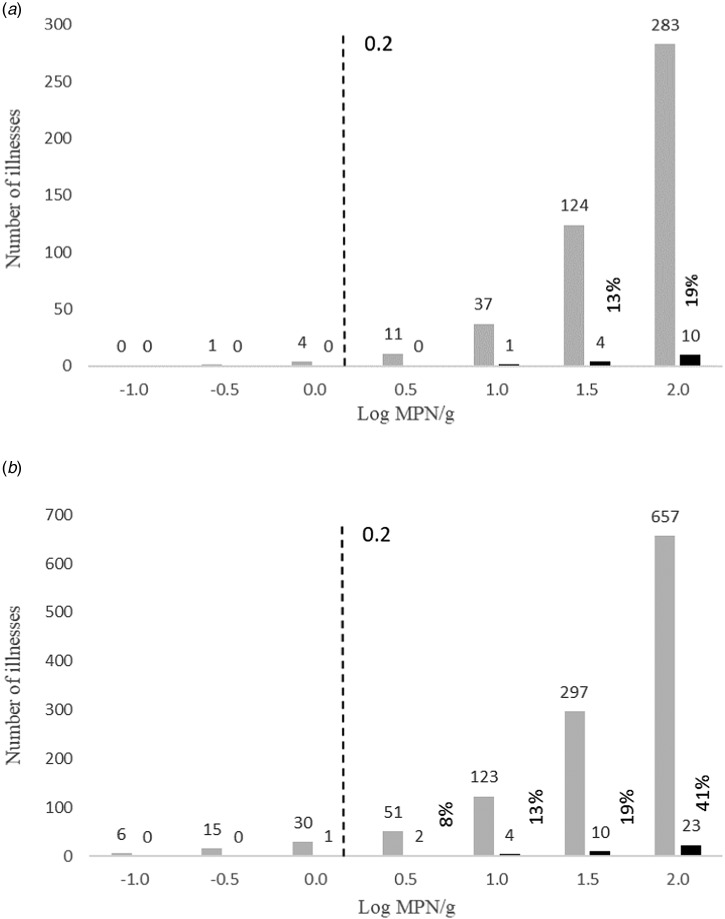
Number of illnesses and reported cases predicted by the feeding trial dose–response model (a) and the outbreak data dose–response model (b) at various contamination levels of a single 2000 lb lot of contaminated ground turkey. Shaded bars correspond to predicted illnesses. Black bars correspond to reported cases. Dotted lines correspond to the mean Salmonella spp. concentration in a positive lot (log MPN/g). Percentages correspond to the probability of a later investigation identifying an outbreak source.